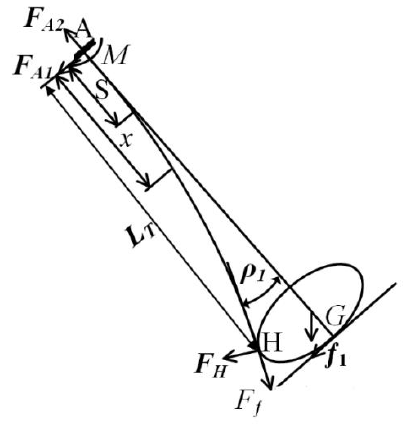
Figure 4. Sketch of the interaction between strip brush and jujube.